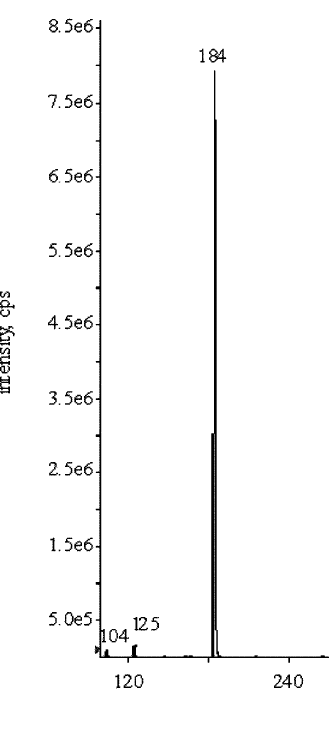
FIG. 4. Positive ion electrospray MS/MS spectrum of the ion at m/z704.